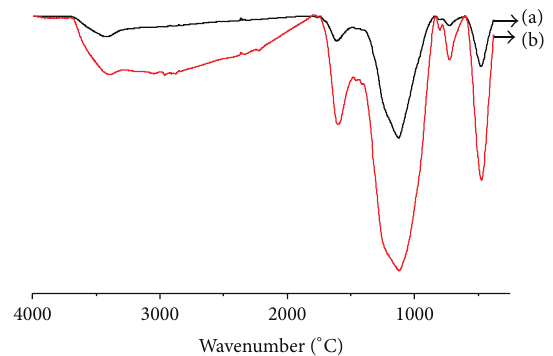
Figure 10: IR Spectra of the residues: (a) flame-retarded PA6 with ADPP; (b) flame-retarded PA6 with ADPP/ME.